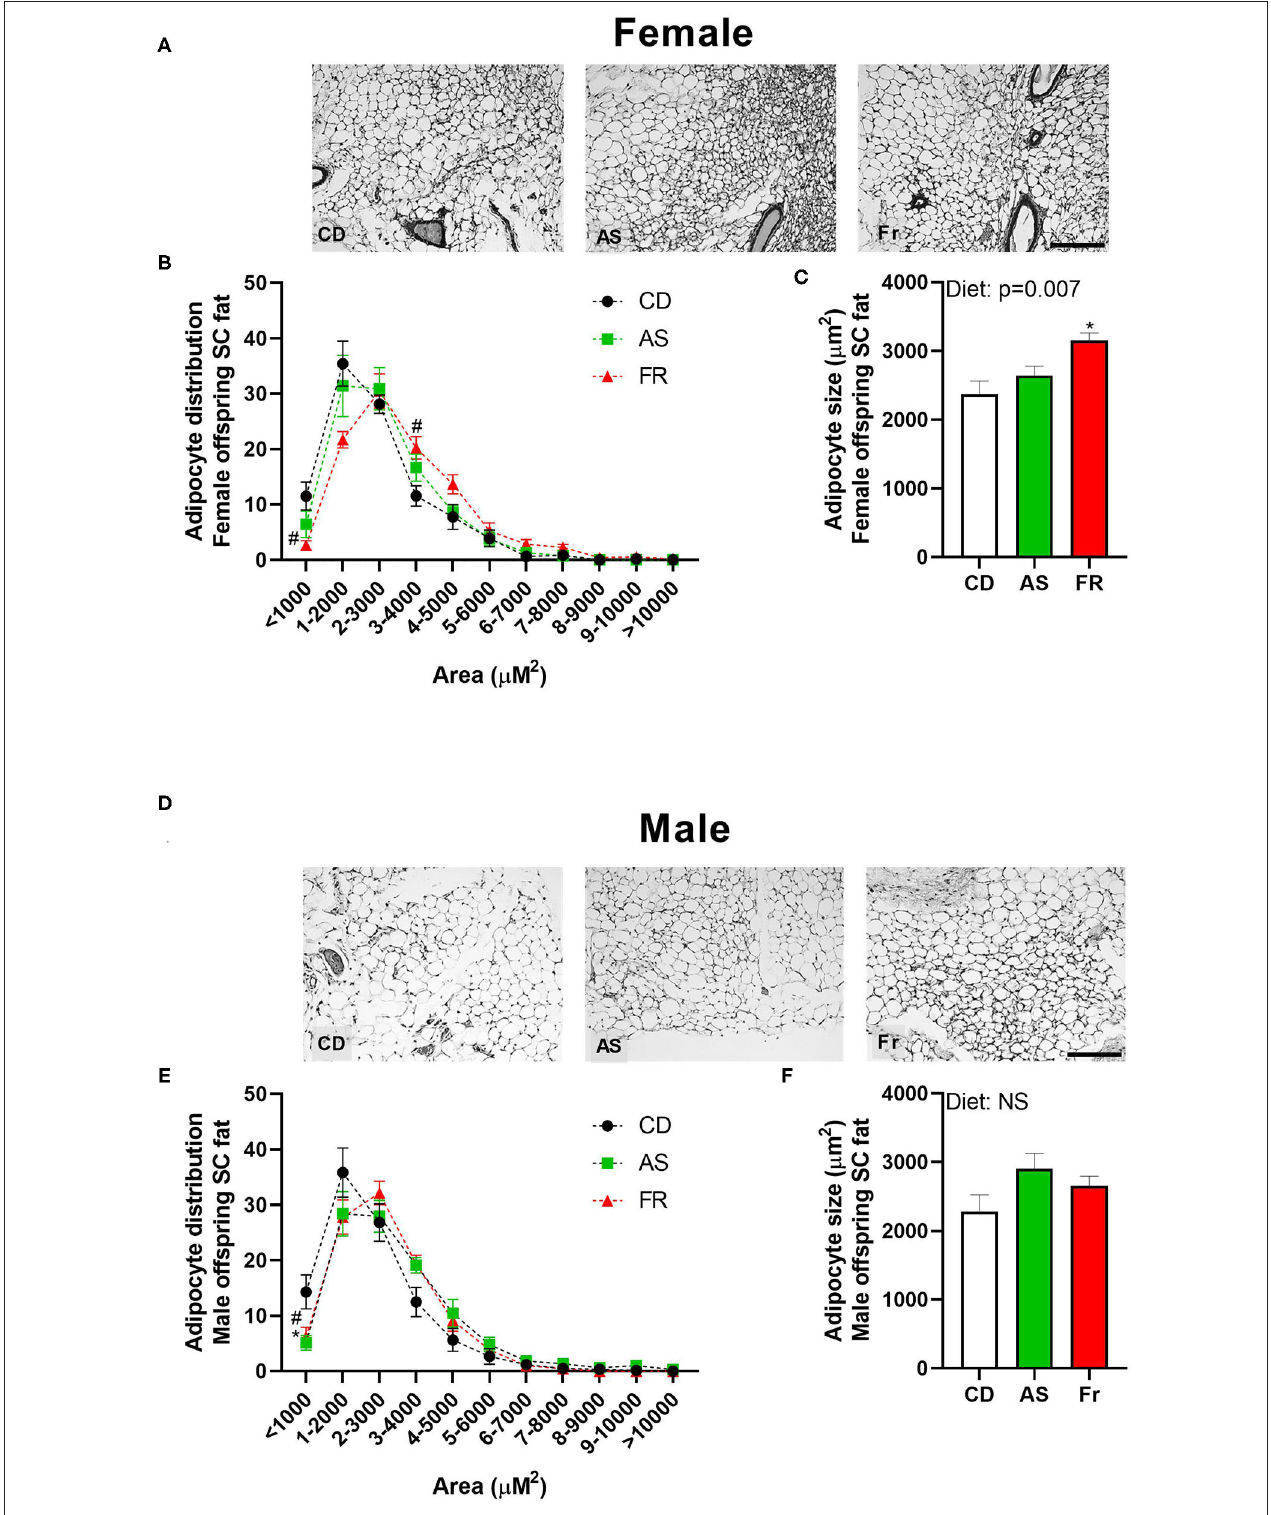
FIGURE 3 | The impact of maternal Ace-K (AS) and fructose (Fr) intake compared to Controls (CD) on adipocyte size in subcutaneous adipose tissue in female and male C57BL/6 offspring. Representative subcutaneous adipose tissue sections (hematoxylin and eosin staining) in female (A) and male (D) offspring. Adipocyte size distribution in female (B) and male (E) offspring. Adipocyte average size in female (C) and male (F) offspring. Data were analyzed by one-way ANOVA. Data are expressed as mean ± SEM. * P < 0.05 AS w.r.t CD. # P < 0.05 Fr w.r.t CD; n = 8 per sex per group.